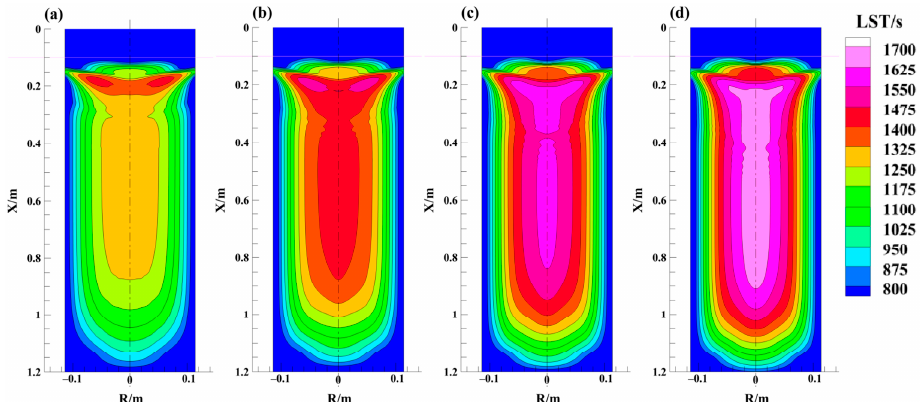
Figure 8. LST distribution at varying melting rate: ( a ) 90 kg/h, ( b ) 120 kg/h, ( c ) 150 kg/h and ( d ) 180 kg/h.